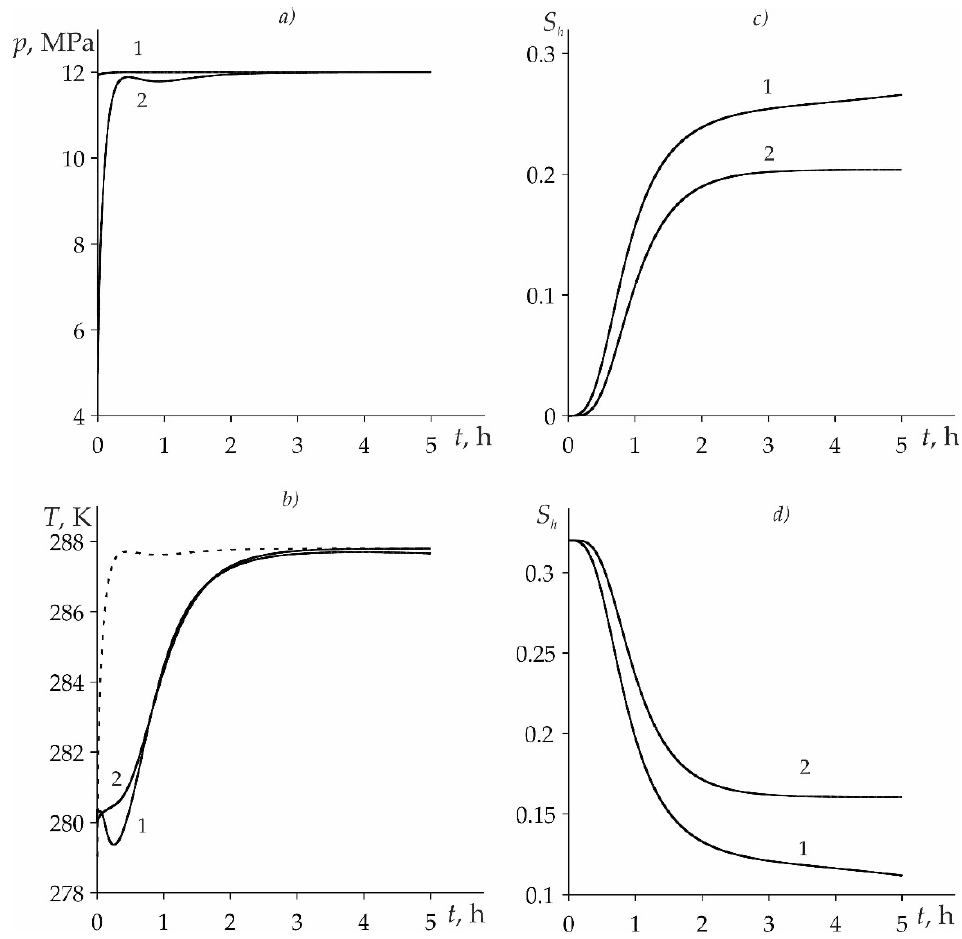
Figure 5. Change over time in pressure ( a ), temperature ( b ), hydrate saturation ( c ) and water saturation ( d ). The dashed line is the equilibrium temperature.